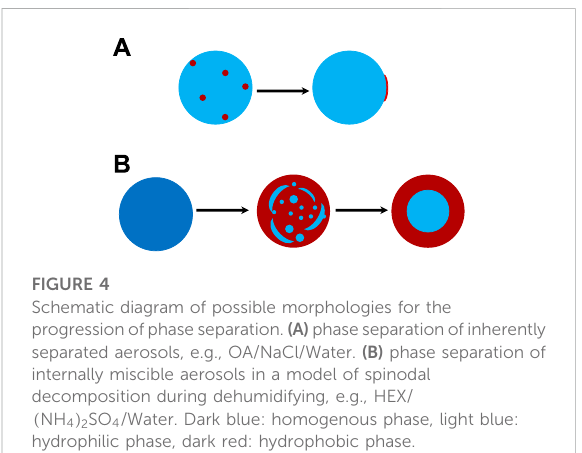
FIGURE 4 Schematic diagram of possible morphologies for the progressionofphaseseparation. (A) phaseseparationofinherently separated aerosols, e.g., OA/NaCl/Water. (B) phase separation of internally miscible aerosols in a model of spinodal decomposition during dehumidifying, e.g., HEX/